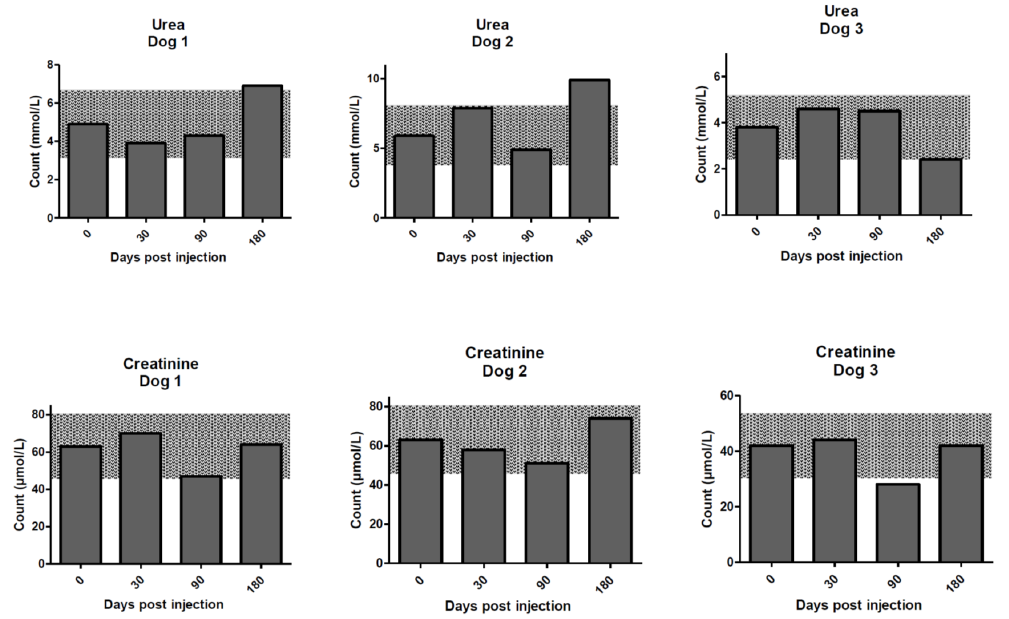
Figure 4. Renal analytes for the dogs on days 0–180 post treatment with 213 Bi-400-2 antibody. Upper row—urea; lower row—creatinine. Shaded areas show reference change values (RCVs).